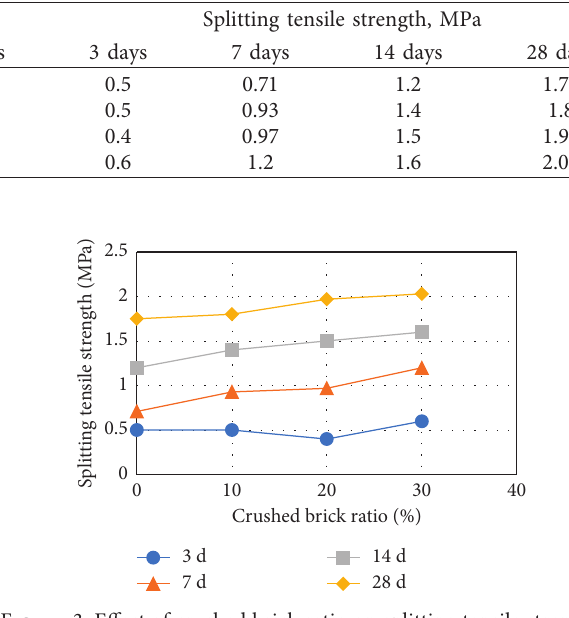
Table 2: Results of compressive strength and splitting tensile strength.